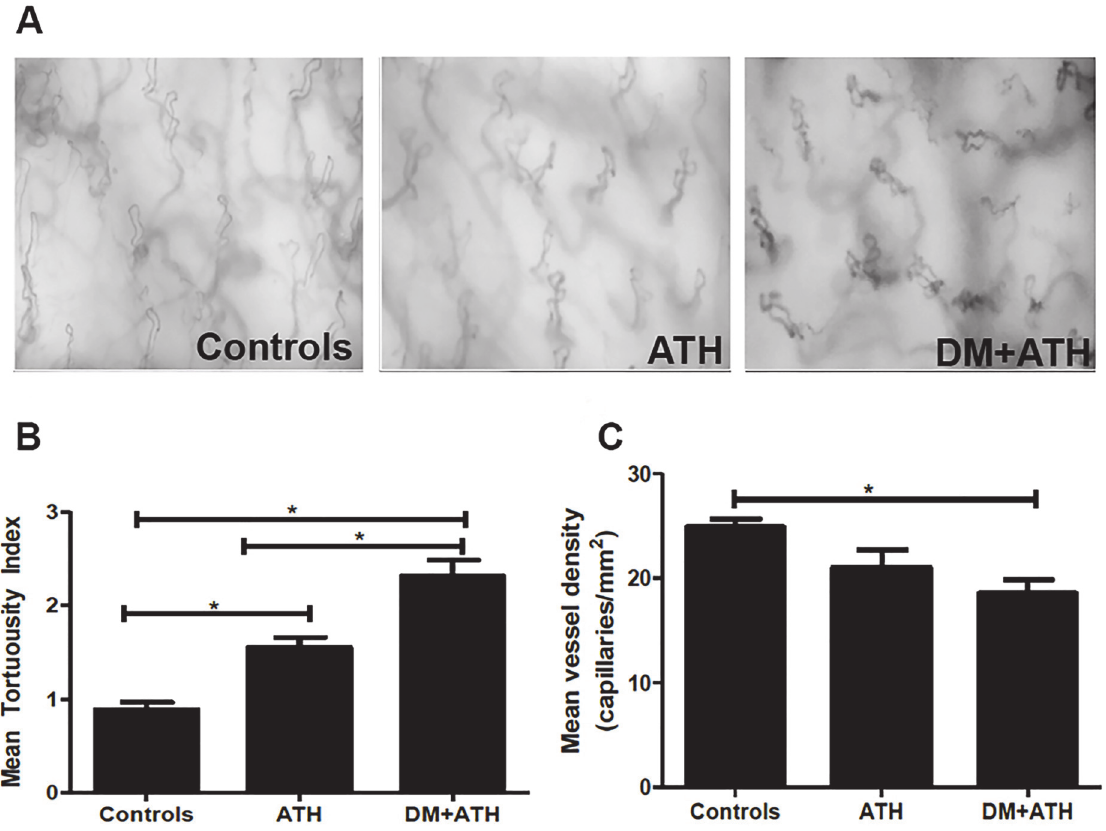
Fig 1. Early atherogenic DM leads to increased capillary tortuosity. A. Sidestream darkfield images of the oral mucosa visualizing the microvascular capillaries of a representative pig in the Controls, ATH and DM+ATH group. B. Mean tortuosity index of microvascular capillaries in the Controls (n = 7), ATH (n = 5) and DM+ATH pigs (n = 5). C. Mean vessel density (capillaries/mm 2 ) in Controls (n = 7), ATH (n = 5) and DM+ATH (n = 5) pigs. Data shown are mean ± SEM. * P < 0.05 compared to Controls or ATH pigs. Mean vessel density (capillaries/mm 2 ) was calculated by evaluation of number of vessels per selected microcirculatory image. Subsequently, tortuosity of capillary loops was assessed according to a validated scoring system (0: no twists to 4: four or more twists) and the average of assessed capillary tortuosity was used to calculate mean tortuosity index per patient.